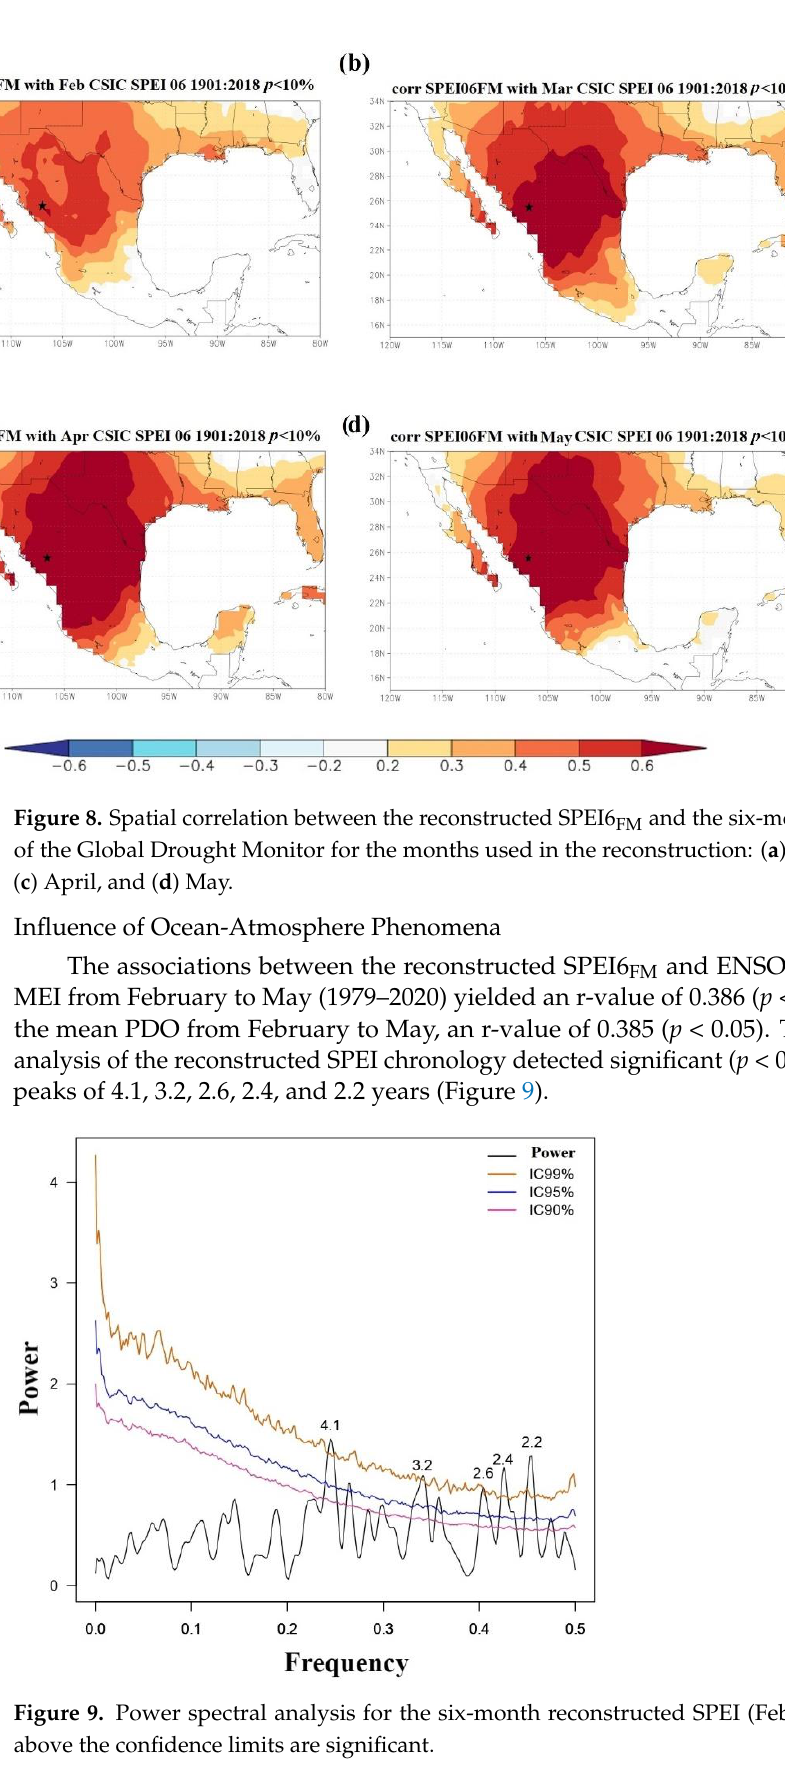
Figure 10. Wavelet coherence analysis for six-month reconstructed SPEI (February – May). Perime- ters marked with a thick dark line within the cone of influence indicate significant areas ( p < 0.05).